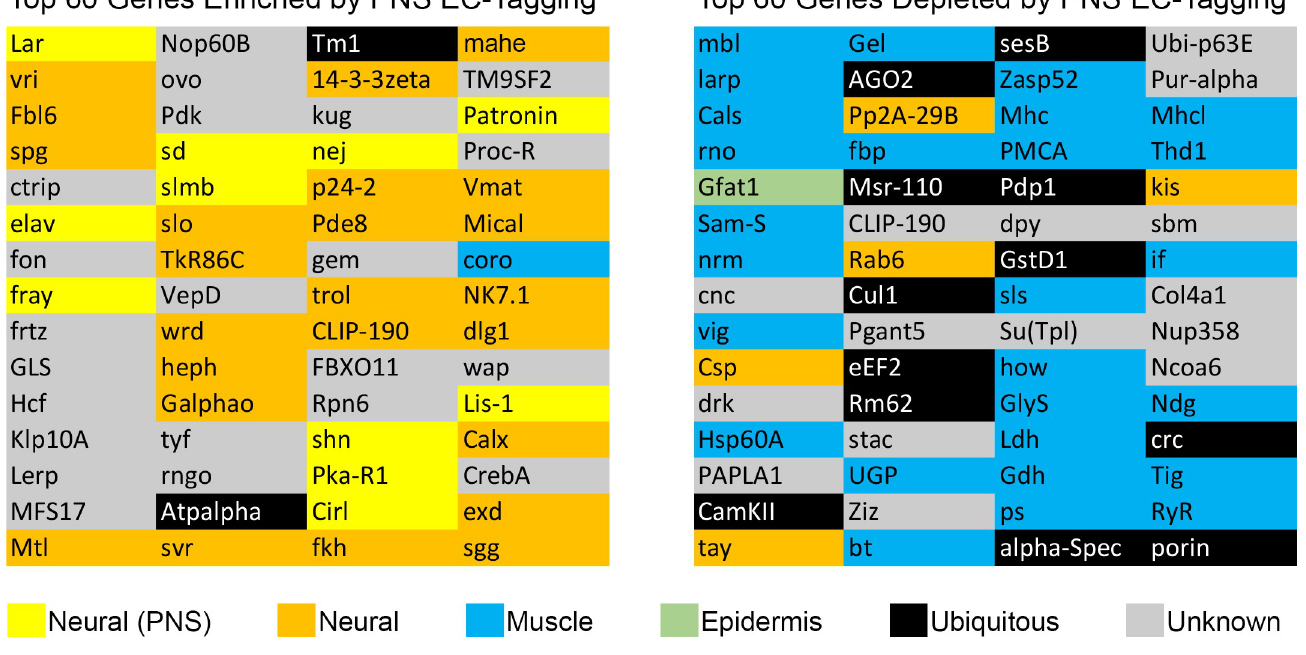
Fig 2. Top md neuron enriched and depleted transcripts. Only named genes are included, genes known only by “CG number” were excluded. The primary tissue expression pattern is color coded. Tissue expression was determined by searching Flybase annotations and published literature. “Neural (PNS)” indicates known expression in larval md neurons. “Neural” indicates expression in the central nervous system at any stage. “Muscle” indicates expression in any type of muscle at any stage. “Epidermis” indicates expression in epidermis at any stage. “Ubiquitous” indicates either widespread expression or evidence of expression in both neurons and muscle. “Unknown” indicates the literature do not support assignment to any of the other